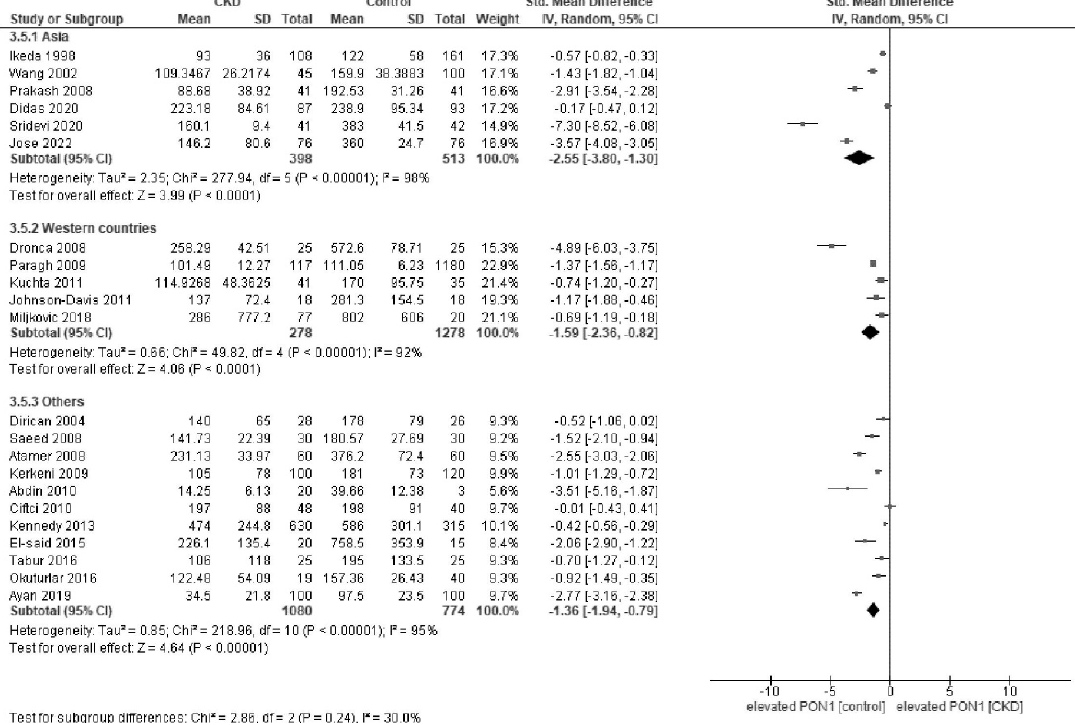
Figure A4. Forest plot of paraoxonase activity stratified by regions [26–42,44,46–49].